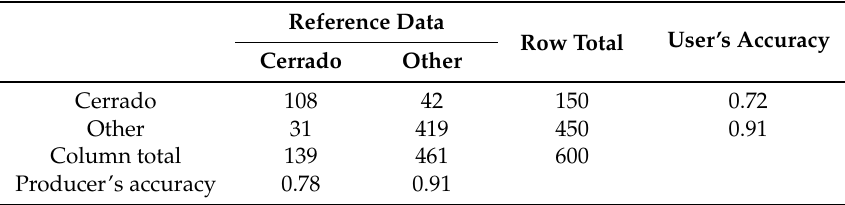
Table 4. Mato Grosso do Sul error matrix for 2014